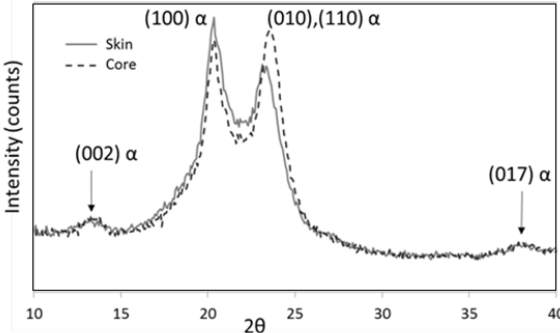
Figure 1. Typical X-ray diffraction for polyamide 66 (PA 66); intensity vs. 2 θ ( θ is the diffraction angle).